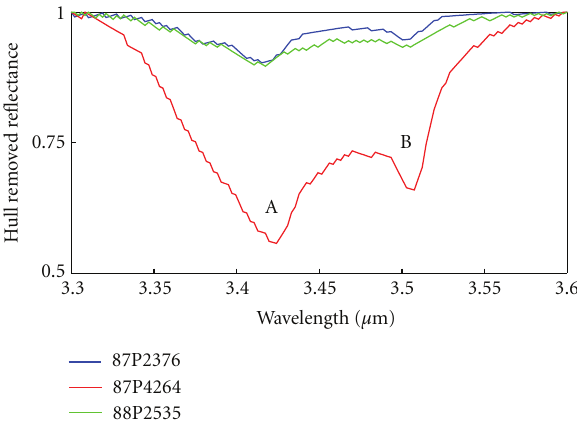
Figure 15: Examples of hull removed 3.3 μ m to 3.6 μ m ASL reflectance spectra (see Figure 11(a)) highlighting organic carbon spectral absorption features at 3.41 μ m (“A”) and 3.5 μ m (“B”) applied to several USDA soil samples.